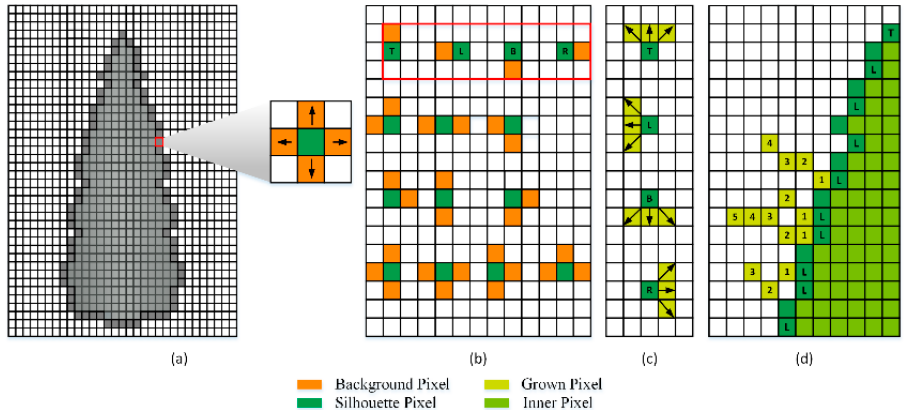
Figure 13. Detection of the crown silhouette and the selective growth of a silhouette pixel: ( a ) the process of image-based silhouette extraction; ( b ) all possible configurations of silhouette pixels and, at the top, the four types (T, L B, R) chosen to be processed; ( c ) three possible growth directions for the pixels; ( d ) an illustration of the growth of silhouette pixels.